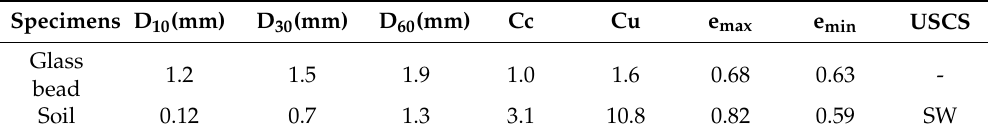
Figure 2. Particle size distributions.